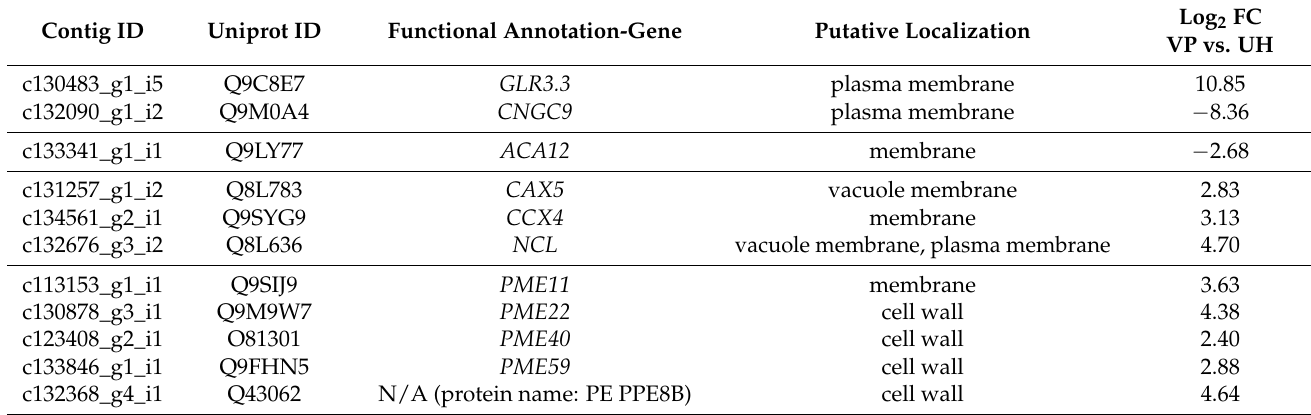
Table 4. Upregulated and downregulated genes between the tipburn-damaged cultivar (VP) and the tipburn-absent cultivar (UH) in the roots.